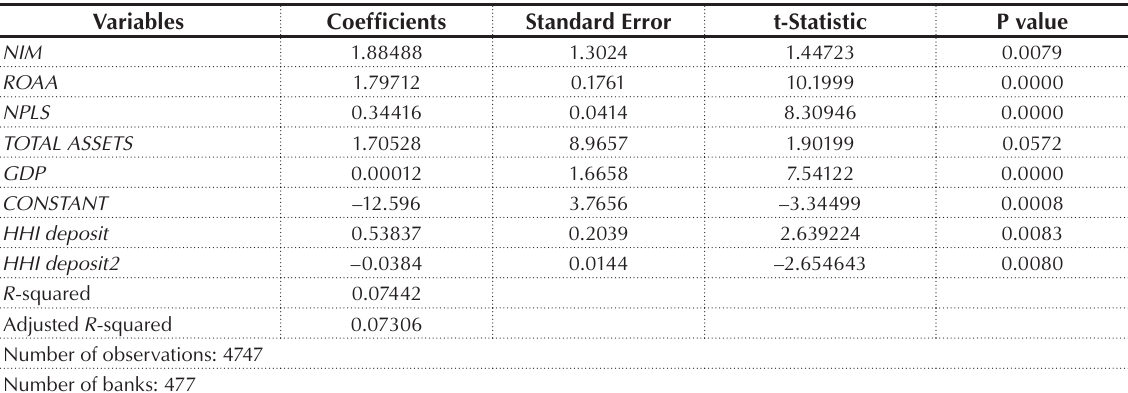
Table 3. (cid:68)(cid:258)(cid:396)(cid:364)(cid:286)(cid:410)(cid:3)(cid:393)(cid:381)(cid:449)(cid:286)(cid:396)(cid:3)(cid:396)(cid:286)(cid:336)(cid:396)(cid:286)(cid:400)(cid:400)(cid:349)(cid:381)(cid:374)(cid:3)(cid:396)(cid:286)(cid:400)(cid:437)(cid:367)(cid:410)(cid:400)(cid:3)(cid:296)(cid:381)(cid:396)(cid:3)(cid:44)(cid:44)(cid:47)(cid:3)(cid:282)(cid:286)(cid:393)(cid:381)(cid:400)(cid:349)(cid:410)(cid:400)(cid:3)